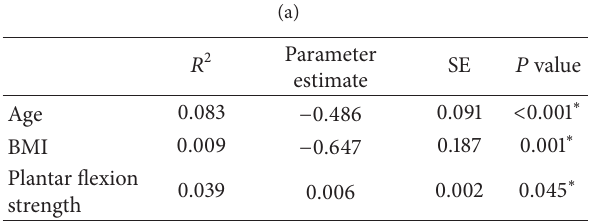
Table 3: (a) Shoulder flexibility regression model. (b) Hip flexibility regression